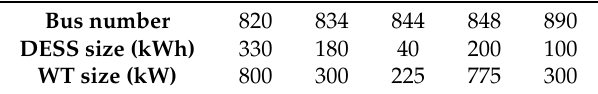
Table 5. System optimization results from the MG perspective with a 10% controllable